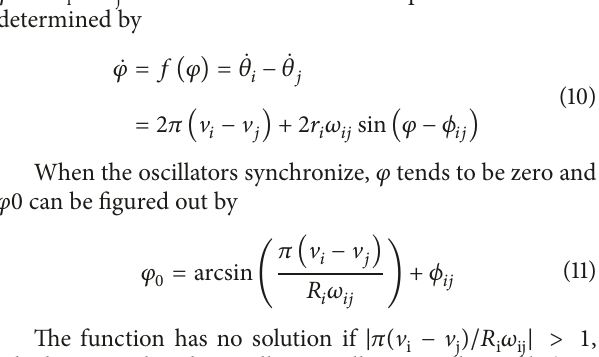
Table 3: Value of 𝜔 ij and Φ ij